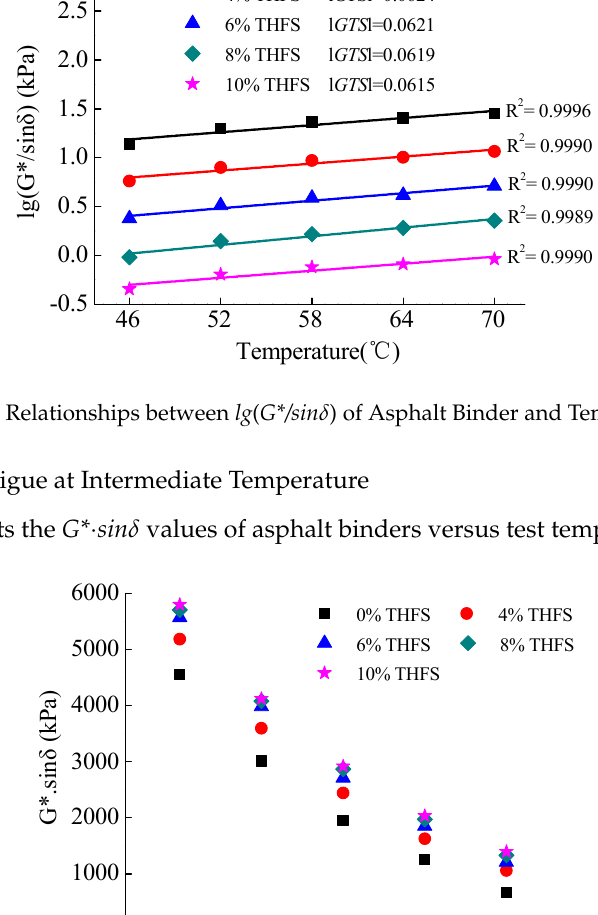
Figure 5 represents the G* · sin δ values of asphalt binders versus test temperatures.